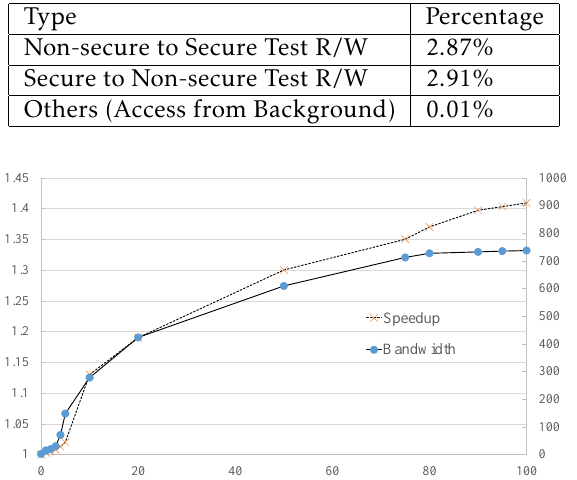
Table 3. TrustZone-Related Instruction Count